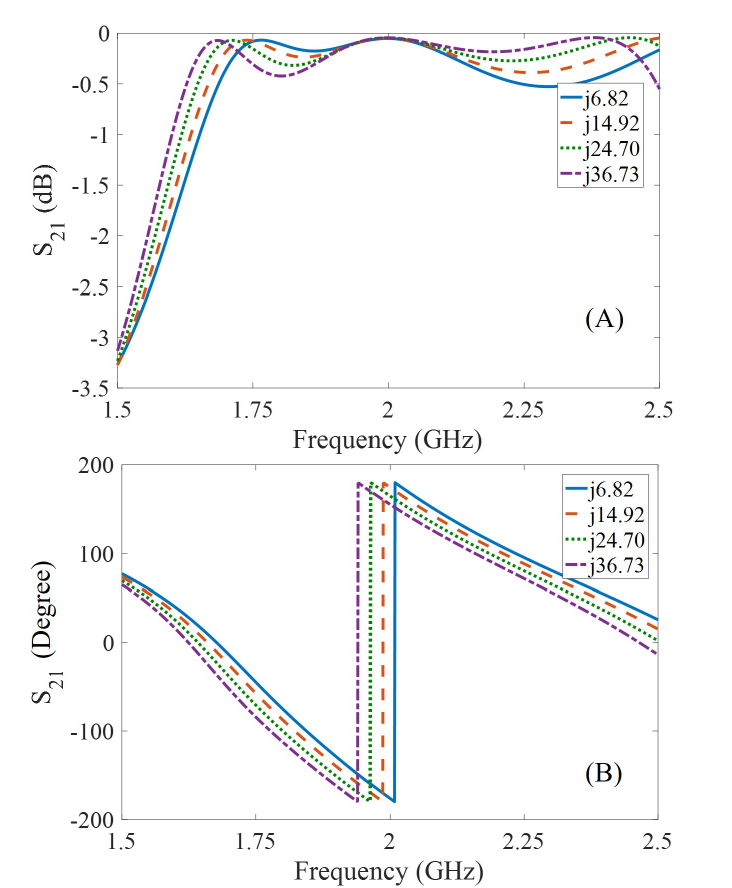
Figure 10. Simulated frequency response of the designed phase shifting hybrid coupler with a variable reactance from 6.82 Ω to 36.73 Ω : ( A ) No power loss is observed at 2 GHz due to changing reactance, ( B ) A total phase shift of 28.55 ◦ is observed at 2 GHz due to changing